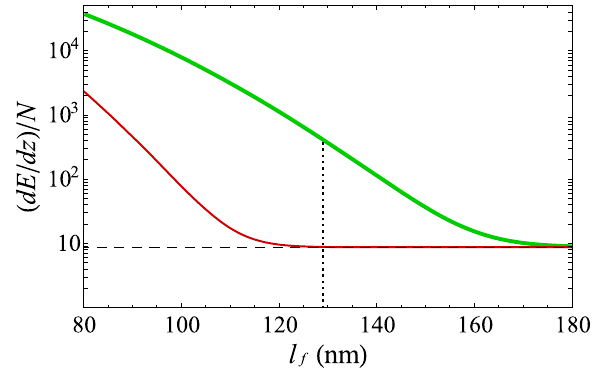
FIG. 3. Dependence of the ensemble ionization loss on l 0 . 75 μ m, n 6 × 10 19 cm − 3 and Gaussian hydrogen for d 0 ¼ f ¼ particle distribution (thick green line). Thin red line, calculation for ¯ ω ¼ I ; dashed line, no coherent effects; the dotted line marks ≈ 130 nm (0.43 the length l f